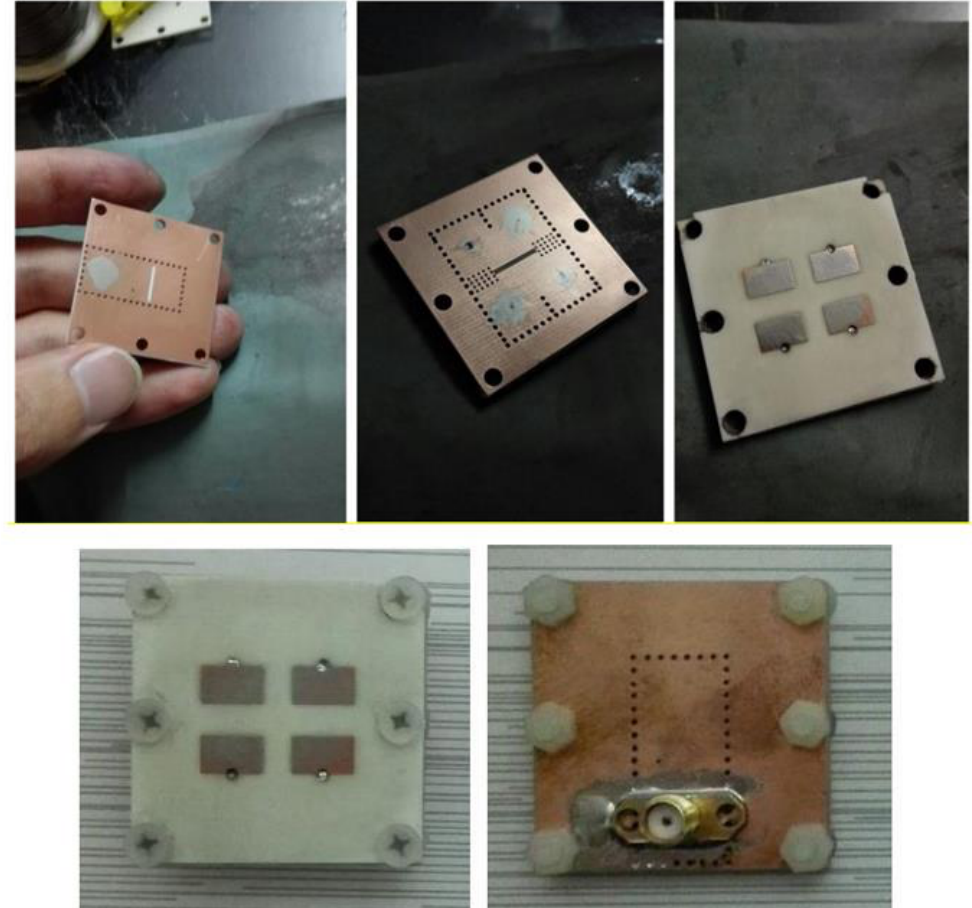
Figure 3. Photographs of the proposed fabricated array.